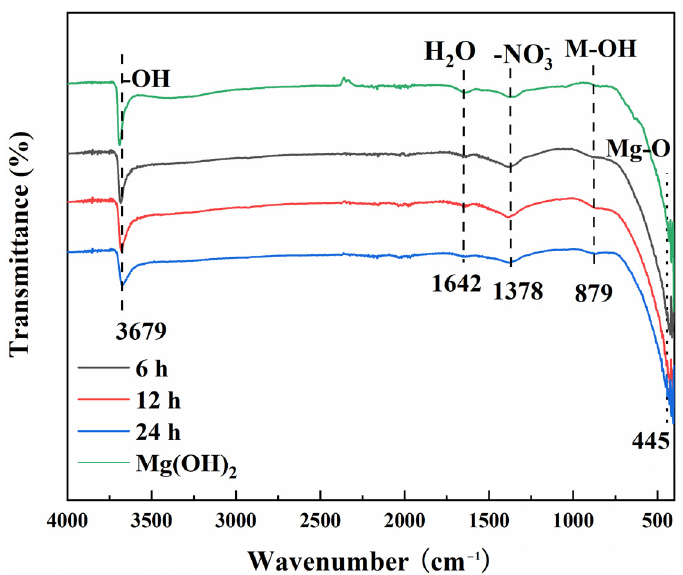
Figure 2. FT-IR spectra of different samples.